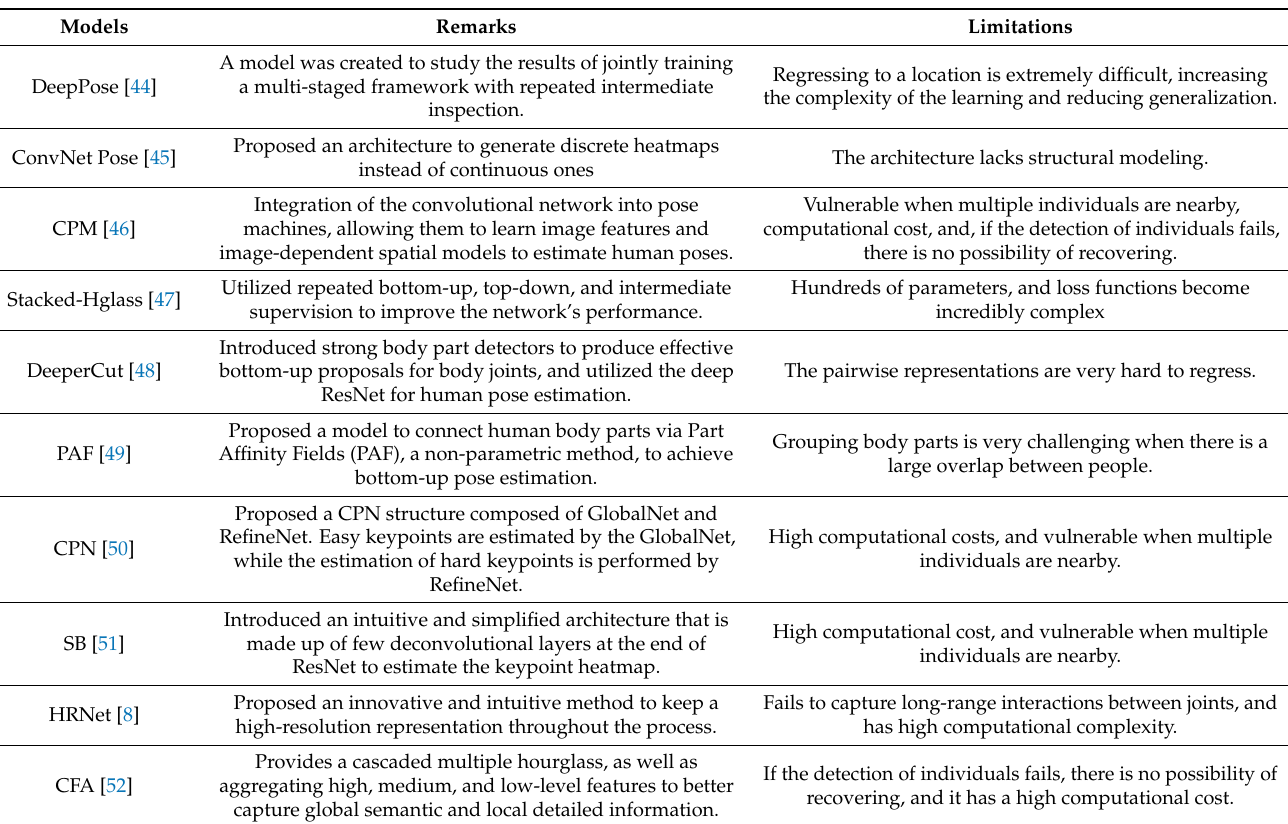
Table 1. Summary of some related works, and their contributions and